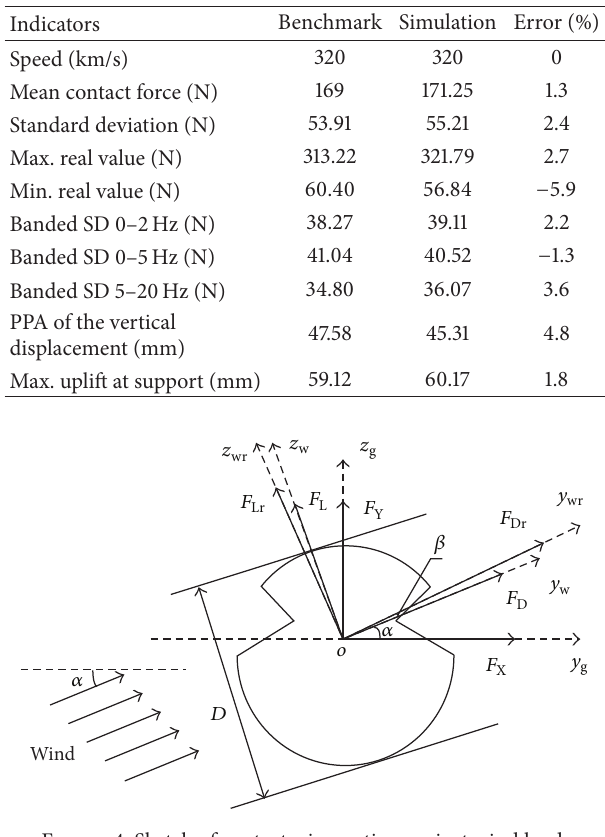
Figure 4: Sketch of contact wire section against wind